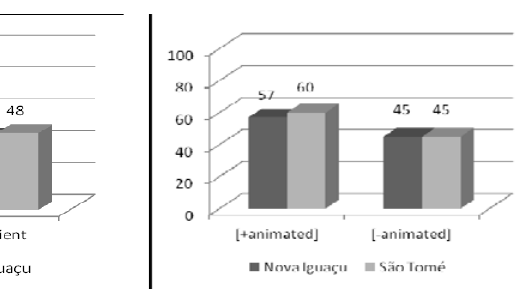
Figure 13. Actuation of the Nucleus Animacy for the application of number mark within the NP, in R.Ws in Copacabana and São Tomé (all education